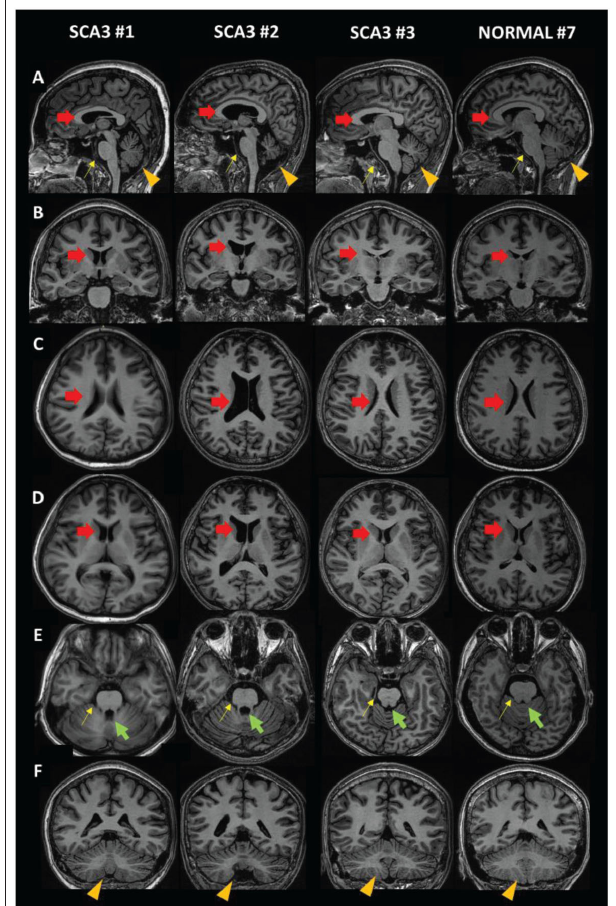
FIGURE 2 | MRI images of SCA3 patients compared to a normal subject. (A) Sagittal view. (B,F) Coronal view. (C–E) Axial view. Red arrow: lateral ventricle (dilated in SCA3); green arrow: fourth ventricle (dilated in SCA3); yellow arrow: brainstem (size reduced in SCA3); orange arrowhead: cerebellum (size reduced in